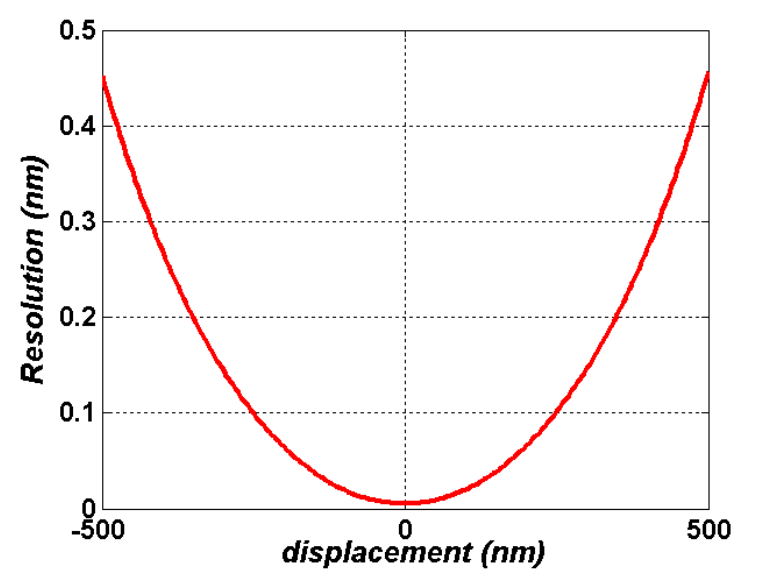
Figure 11. The theoretical displacement resolution of the small-displacement